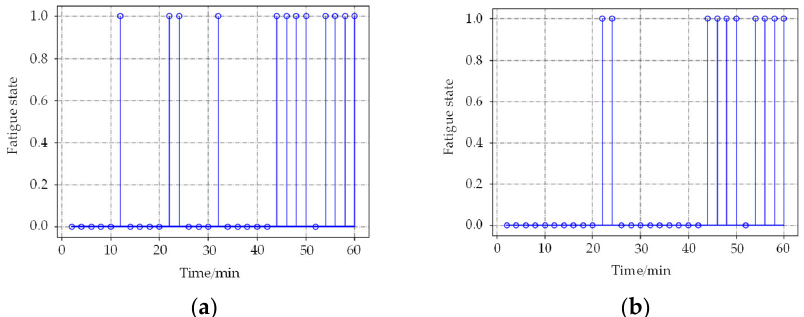
Figure 9. Detection results of the two methods when the time window is 120 s. ( a ) shows results based on the BP neural network; ( b ) shows results based on the time accumulation model.